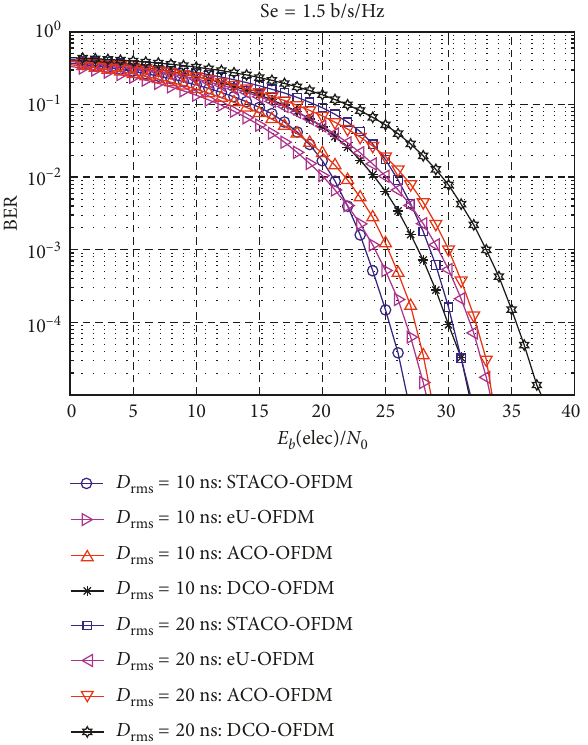
Figure 8: BER versus electrical SNR performance of STACO- OFDM, ACO-OFDM, and DCO-OFDM with spectral efficiency of 1.5bits/s/Hz over multipath channel with D rms